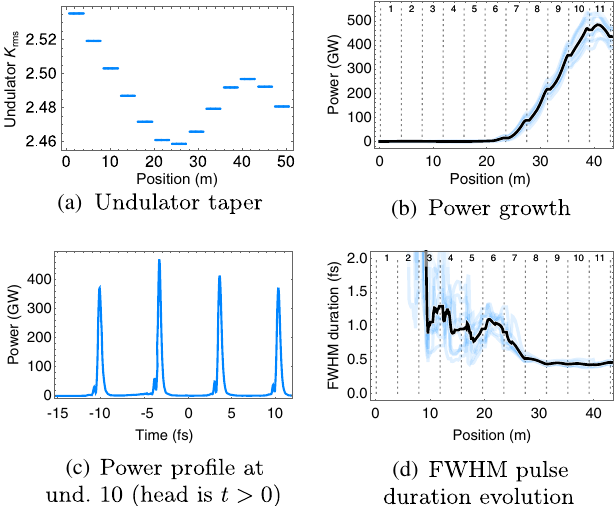
FIG. 2. Sinusoidal chirp-taper simulation results. The black lines in (b) and (d) each show the average of ten shots with different random seeds (shown in light blue). Undulator sections are demarcated by dashed vertical lines with the undulator index shown at the top of the plot ’ s frame for reference.